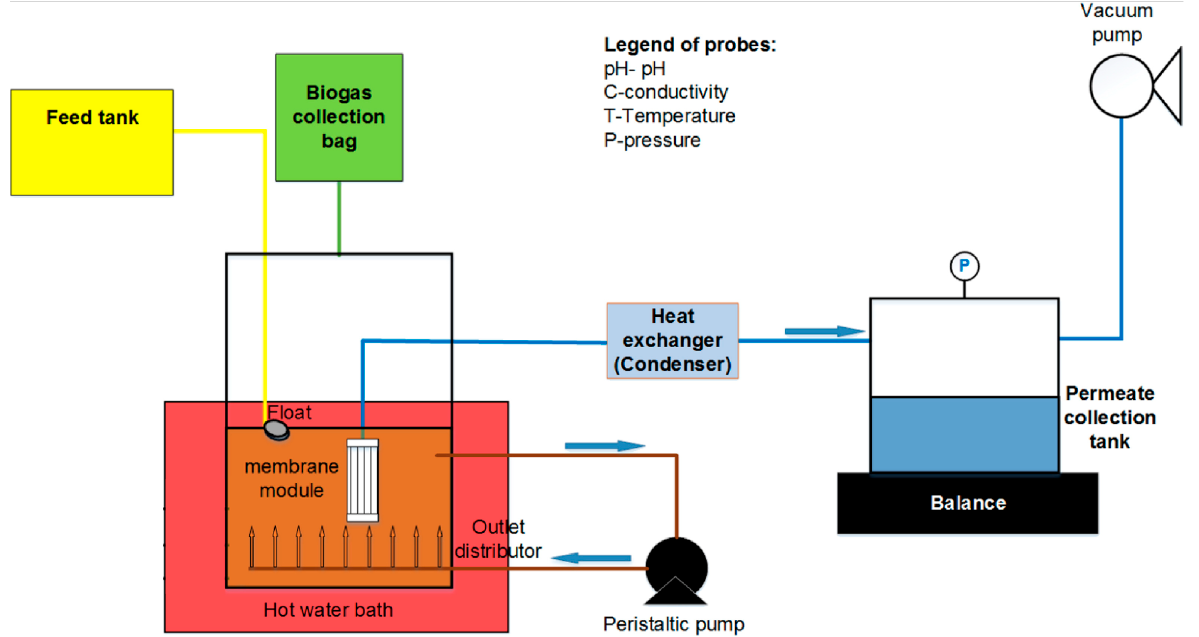
Figure 3. Schematic of AnMDIBRs. (Source: [119]; copyright permission received on 15 February 2023, from Elsevier).